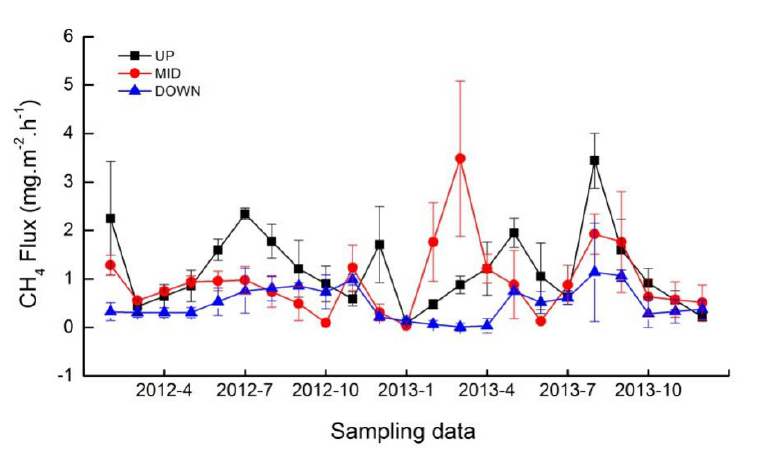
Figure 4. Seasonal variations in CH 4 flux in the three regions.